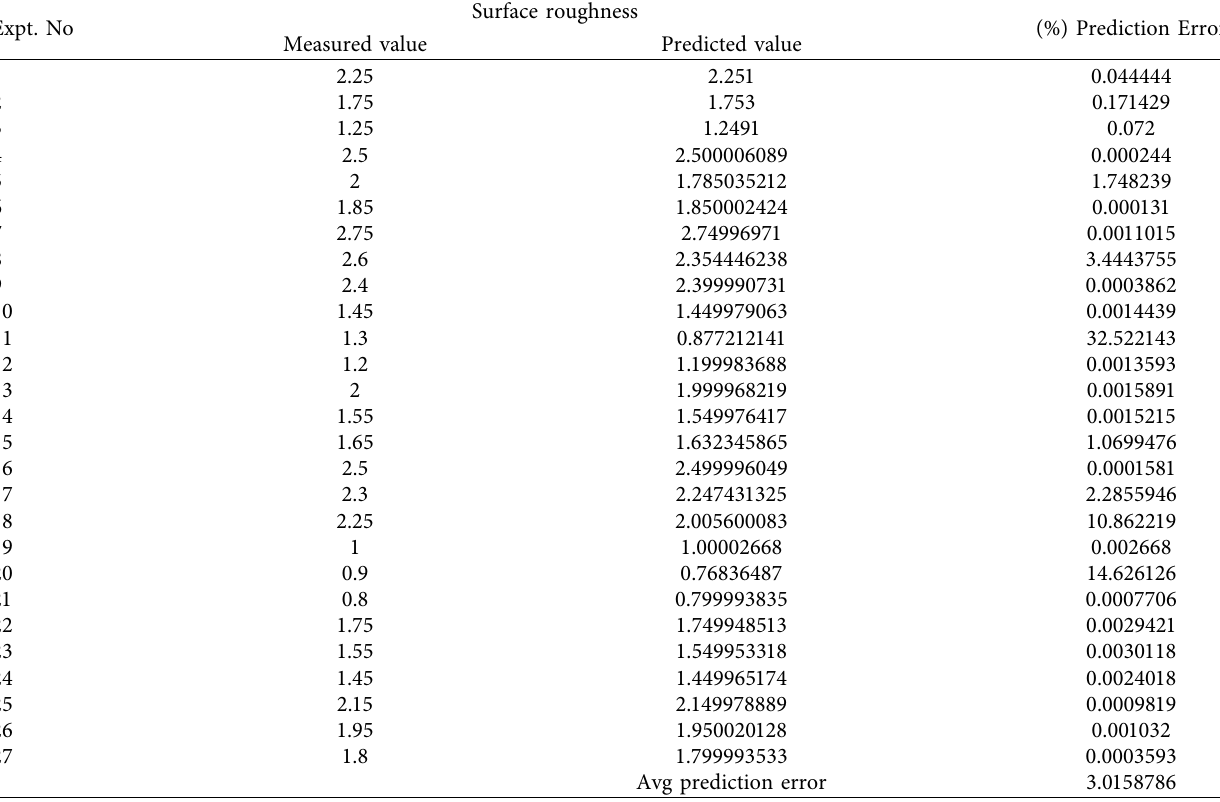
Table 4: Percentage prediction